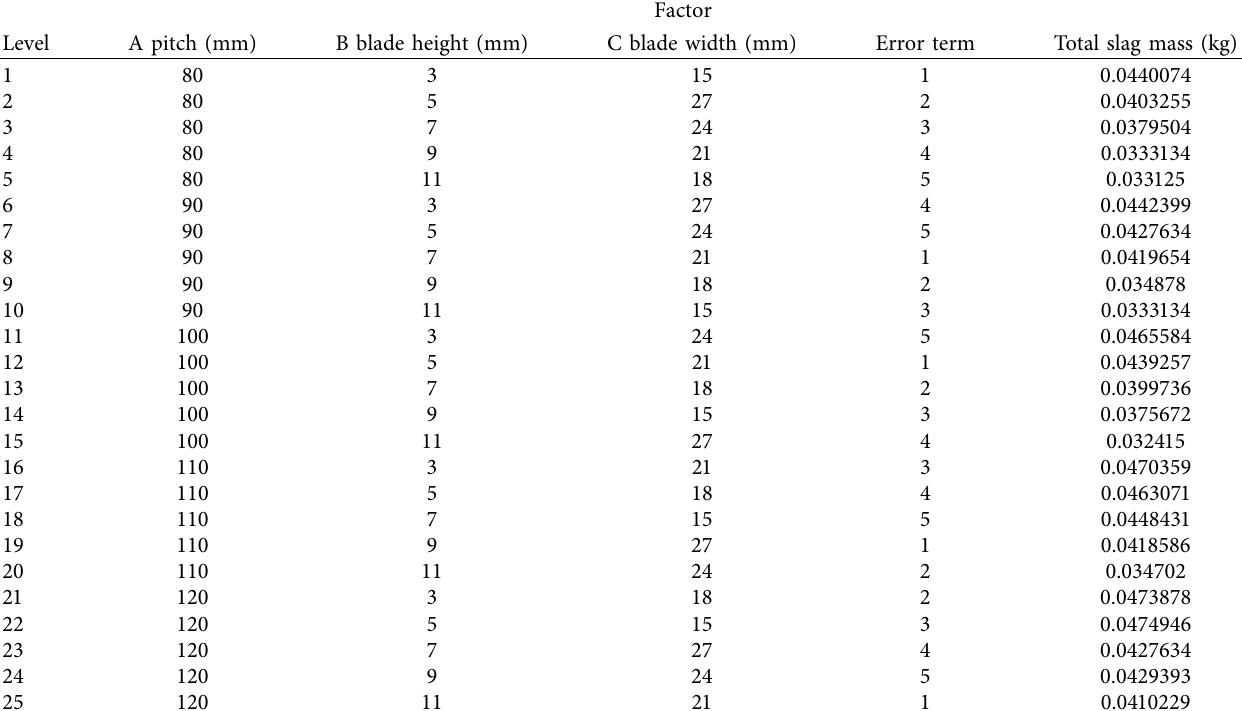
Table 5: Simulation result.